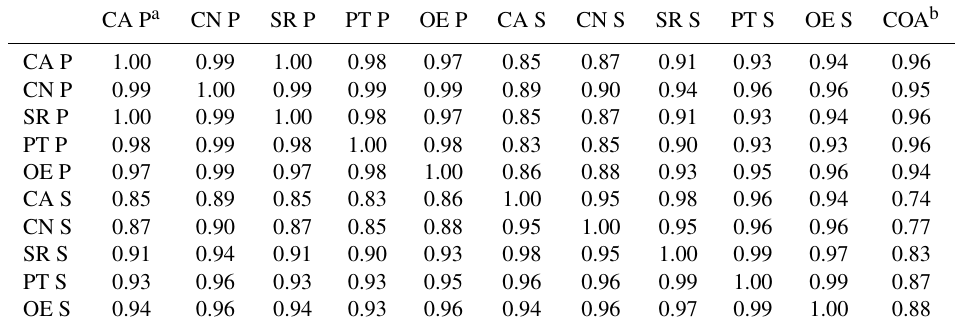
Table 2. Correlation coefficients ( R 2 ) between POA and SOA UMR mass spectra and ambient COA resolved by PMF.